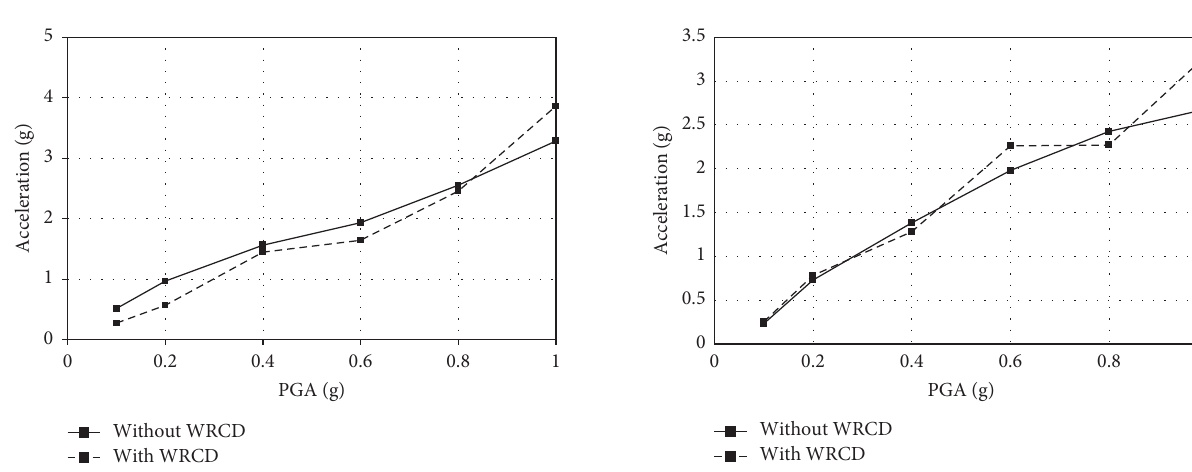
Figure 10: Maximum acceleration of 4# sliding pier top.